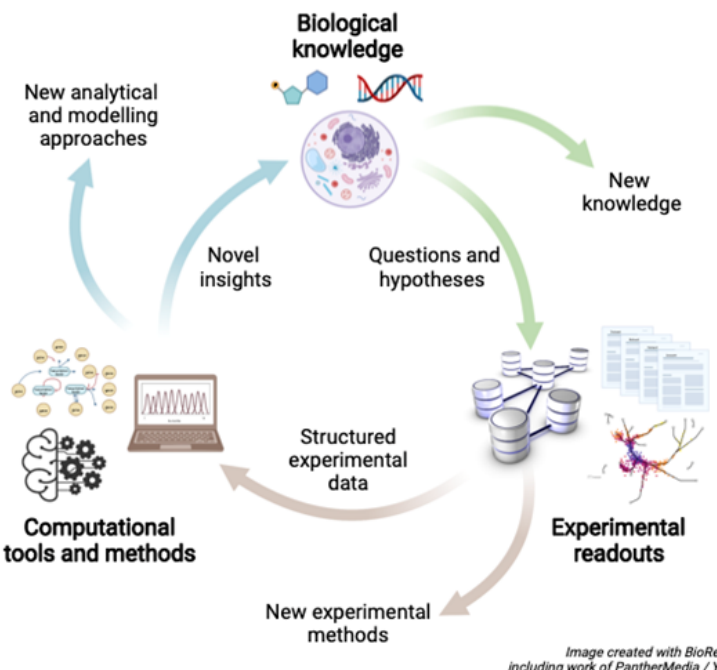
Figure 1. The systems biology “cycle”. To address a particular biological question, the cycle may start by data- and/or hypothesis- driven modelling of the system being addressed, followed by the generation of testable hypotheses, sets of predictions and design of the subsequent laboratory experiment. The experiment is carried out, data are generated and this is followed by computational analysis of these data, comparison of prediction to experiment and refinement of the model, which ultimately leads to gaining insights and generating new hypotheses. This cycle builds upon essential disciplines from Biology (the scientific question), Technology (experimentation and generation of data) and Computation (data analysis, modelling and prediction). Although the diagram is a cycle, it represents a spiral: with every turn data, knowledge and models increase, which could be seens as the cycle spiralling out of the plane of the